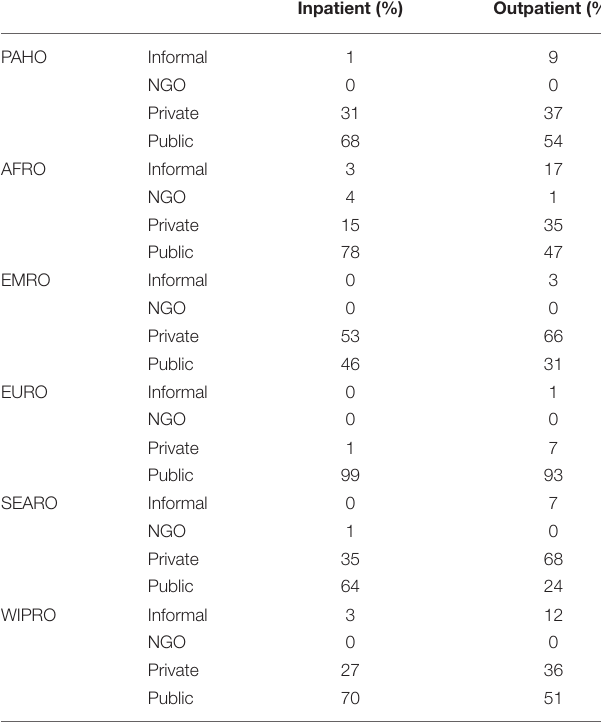
Inpatient (%) Outpatient (%)